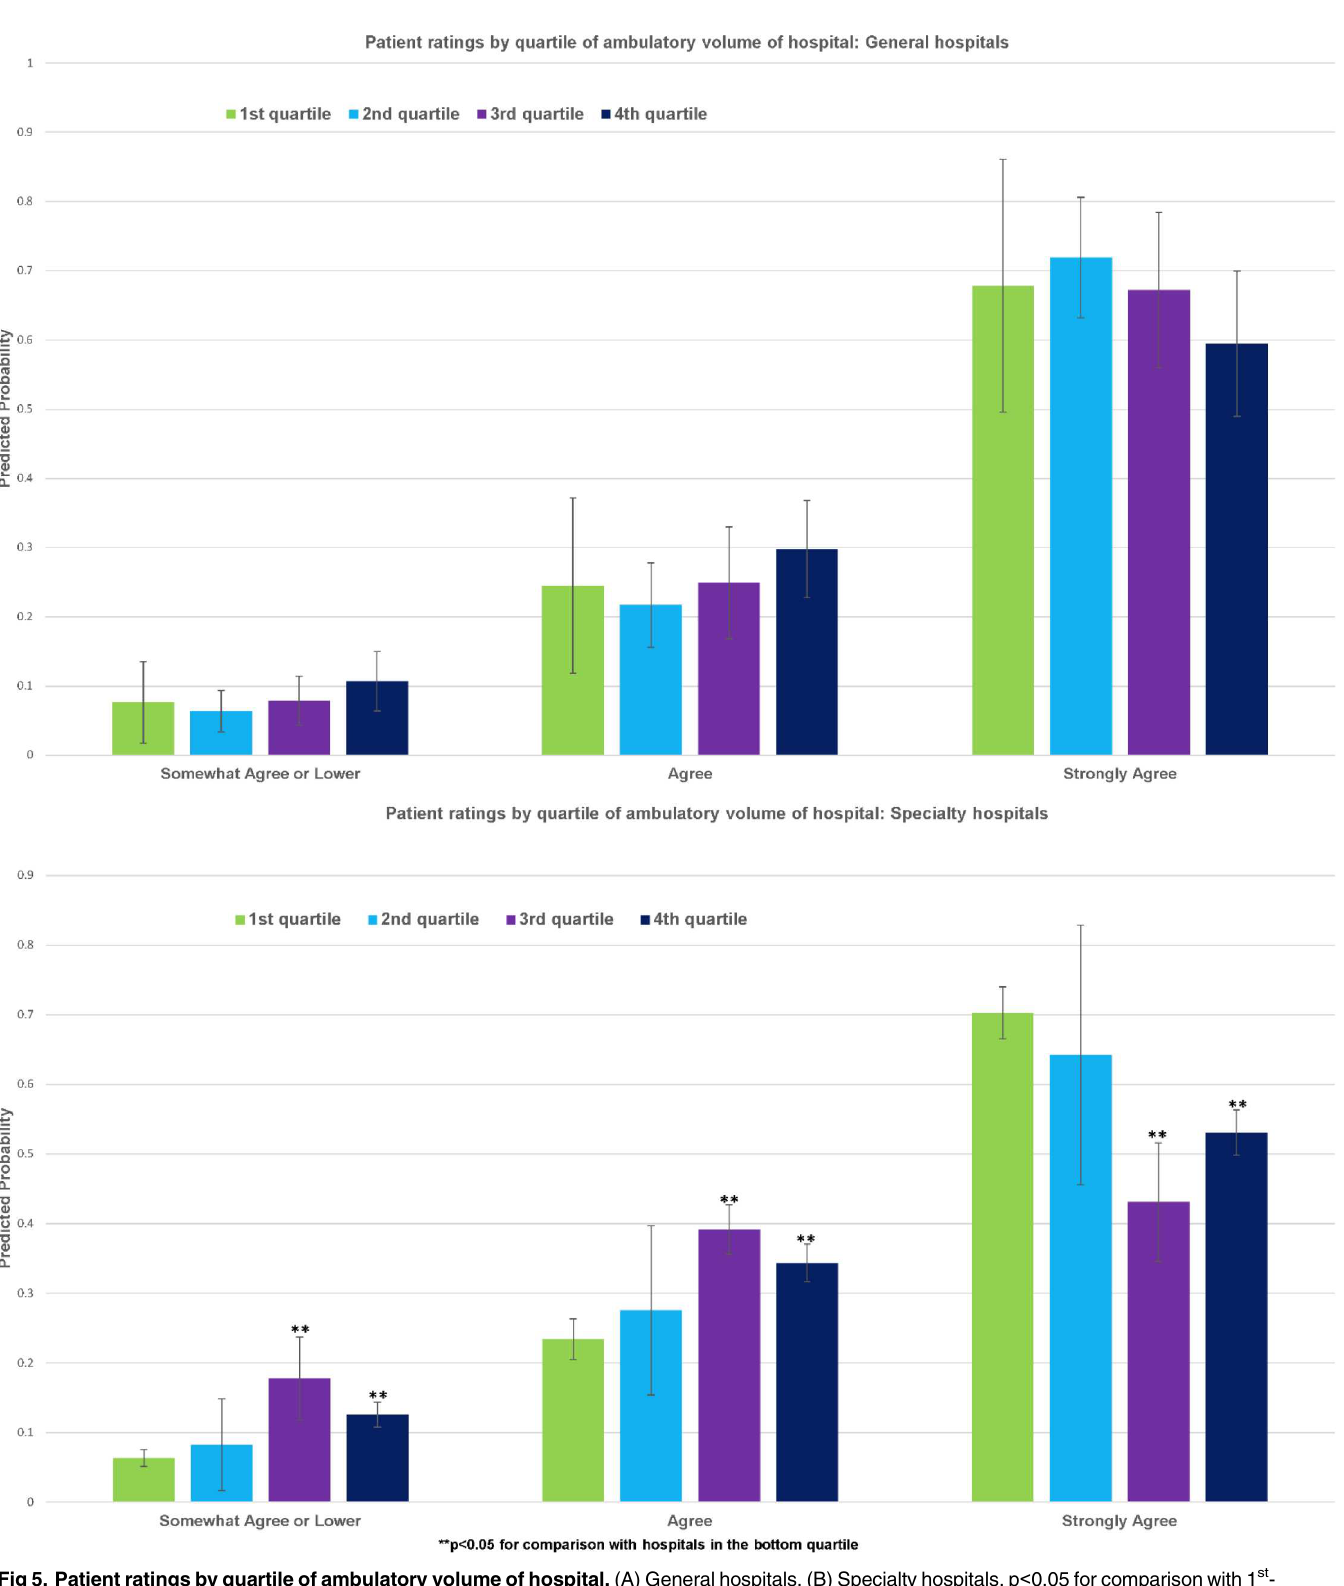
Fig 5. Patient ratings by quartile of ambulatory volume of hospital. (A) Generalhospitals.(B) Specialty hospitals.p < 0.05for comparisonwith 1 st - quartilehospitals.